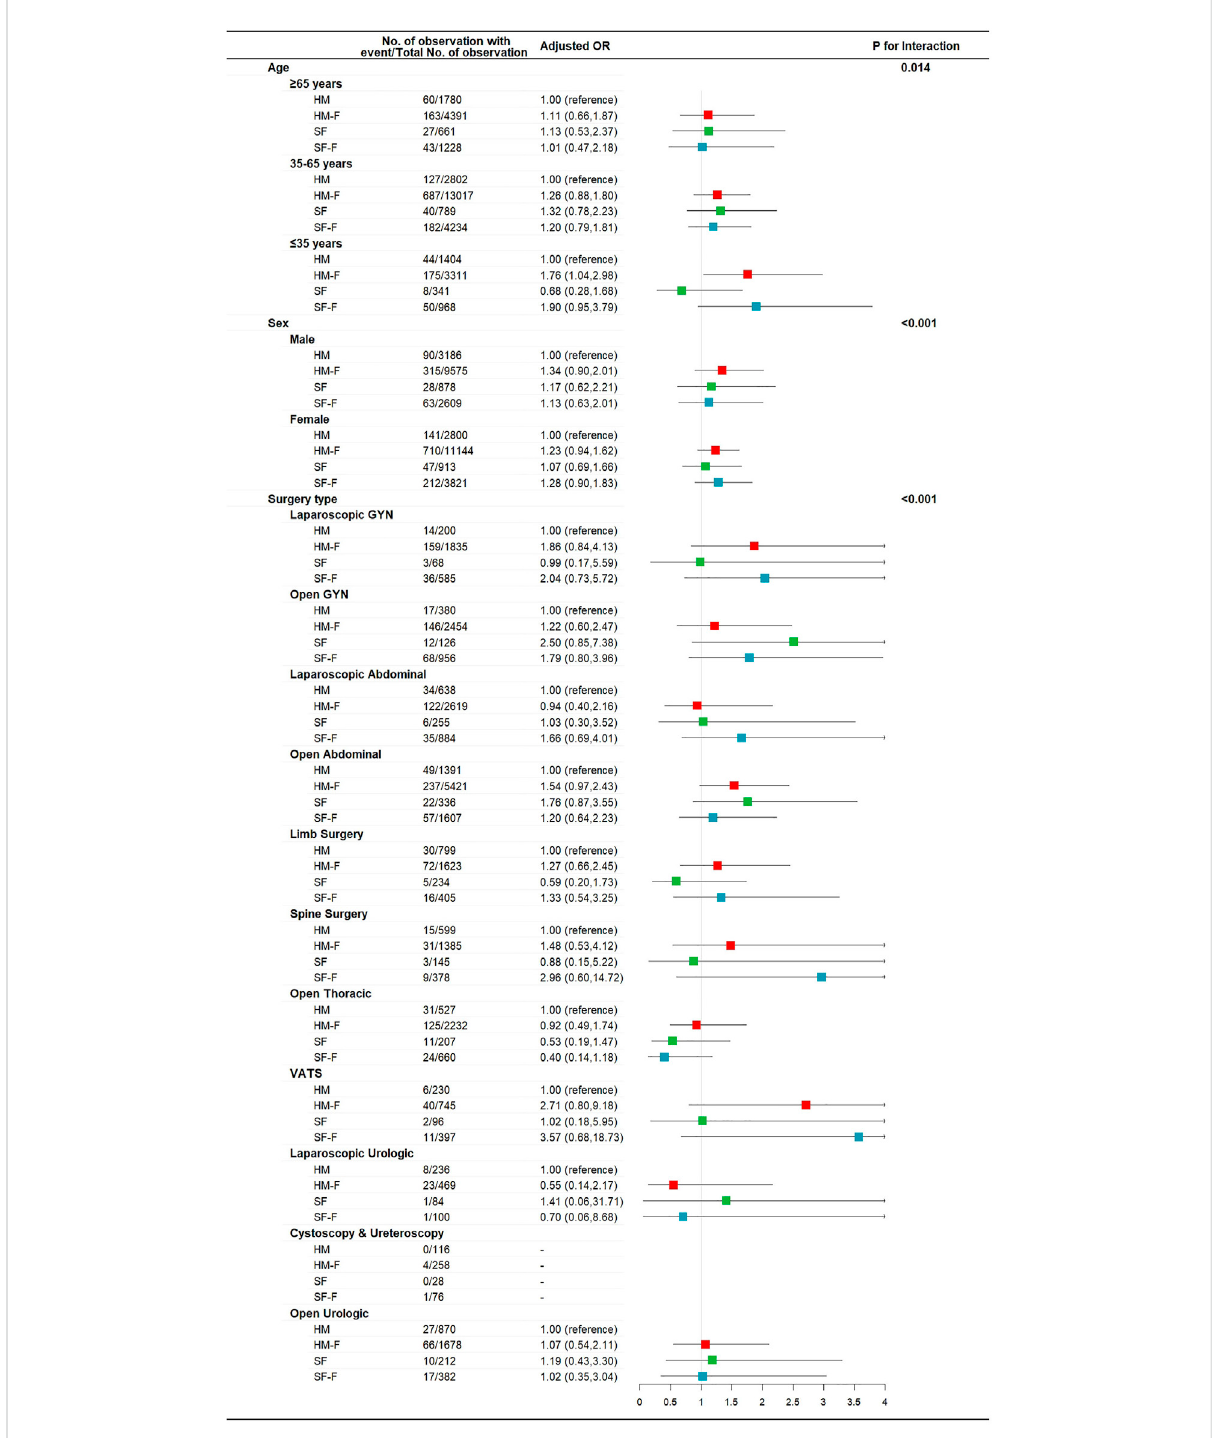
FIGURE 3 RiskofdizzinessforpatientsreceivinghydromorphoneplusFBP,sufentanil,orsufentanilplusFBPforIV-PCA,ascomparedtopatientsreceiving hydromorphone, strati fi ed according to patient age, sex, and surgery